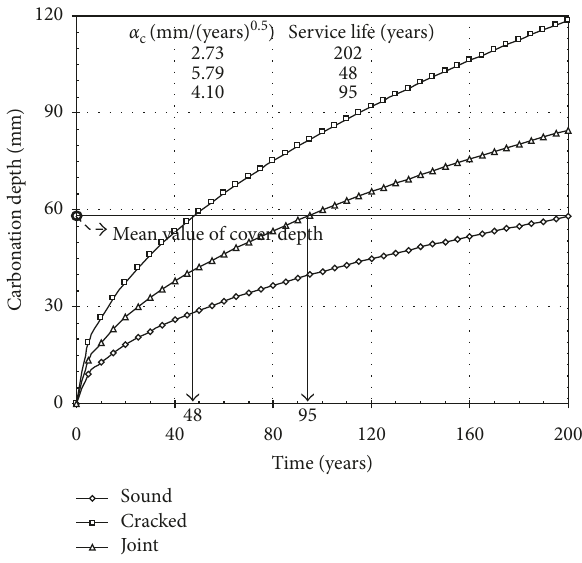
Figure 9: Factored carbonation depth over time for sound, cracked, and jointed concrete cover.